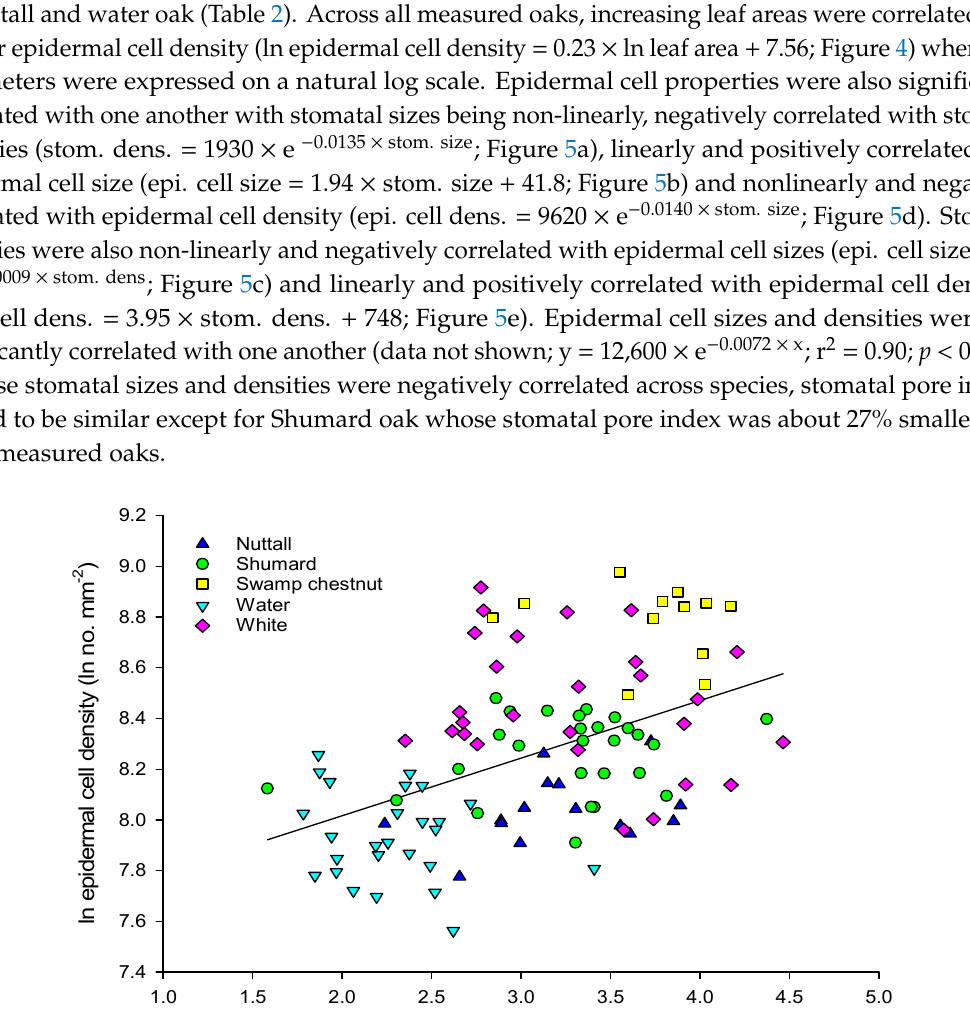
Figure 5. Regressions of leaf epidermal properties including ( a ) stomatal density (no. mm − 2 ) vs. stomatal size ( μ m 2 ; r 2 = 0.55; p < 0.0001), ( b ) epidermal cell size ( μ m 2 ) vs. stomatal size (r 2 = 0.58; p < 0.0001), ( c ) epidermal cell size vs. stomatal density (r 2 = 0.60; p < 0.0001), ( d ) epidermal cell density (no. mm − 2 ) vs. stomatal size (r 2 = 0.49; p < 0.0001) and ( e ) epidermal cell density vs. stomatal density (r 2 = 0.57; p < 0.0001) for Nuttall (dark blue, up triangle), Shumard (green circle), swamp chestnut (yellow square), water (light blue down triangle), and white oak (magenta diamond).